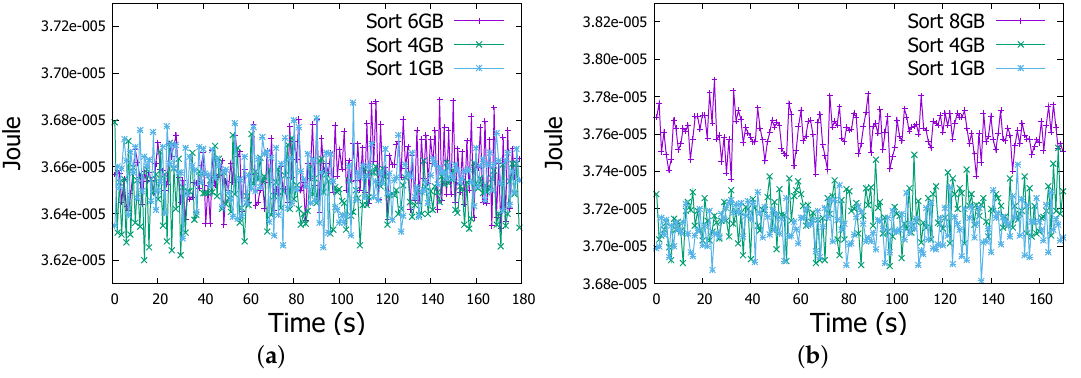
Figure 8. Energy measurement in a Raspberry Pi Worker node in Sort job. ( a ) Sort job (1-4-6 GB files); ( b ) Sort job (1-4-8 GB files).